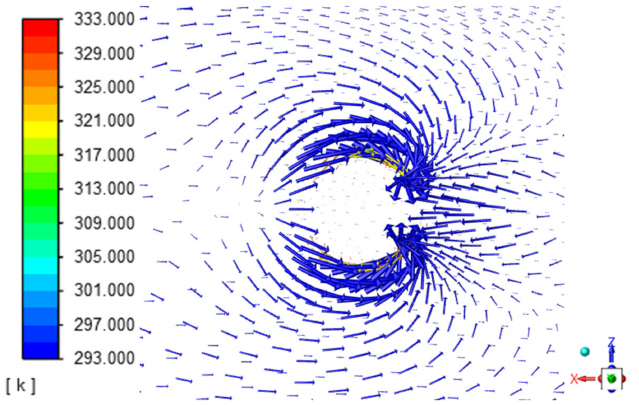
Figure 5. Local velocity vector diagram of the thermal jet from the circle discharge